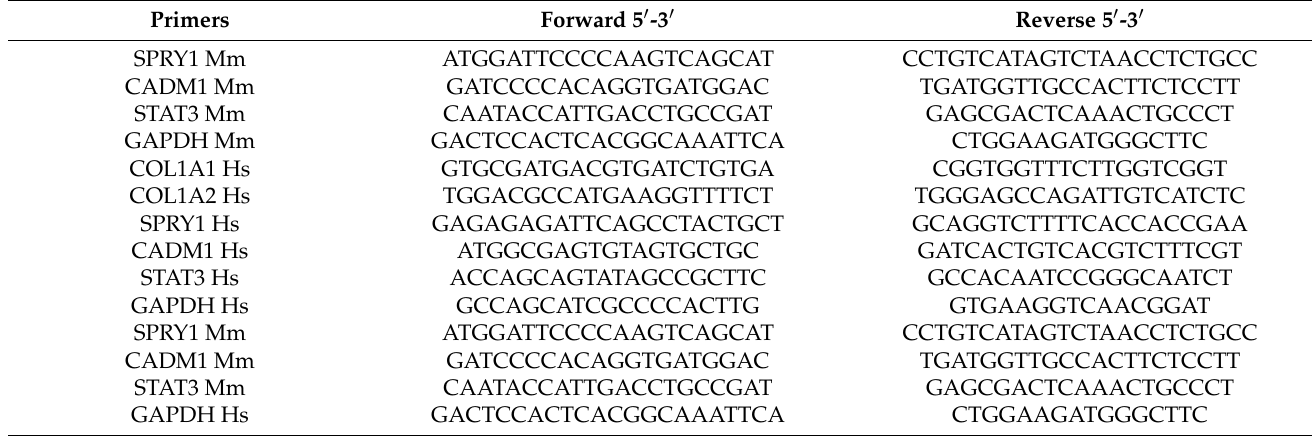
Table 1. Primer sequences used in the RT-qPCR